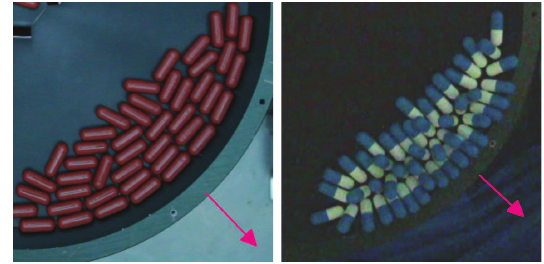
Figure 3. Passive (left) and active (right) grains after sedimentation at the bottom of the vibration dish, 4 ◦ tilt in the direction of the arrows, excitation with 1 . 6 g